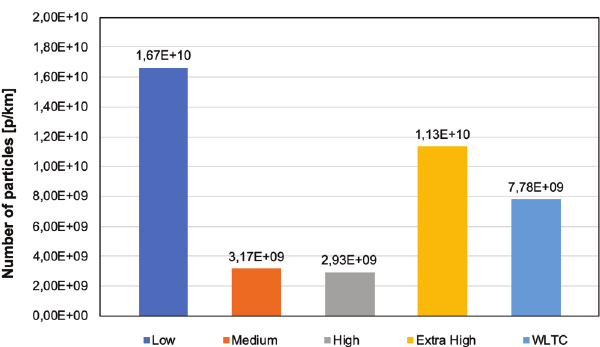
Fig. 7. Particle numbers in WLTP and its phases